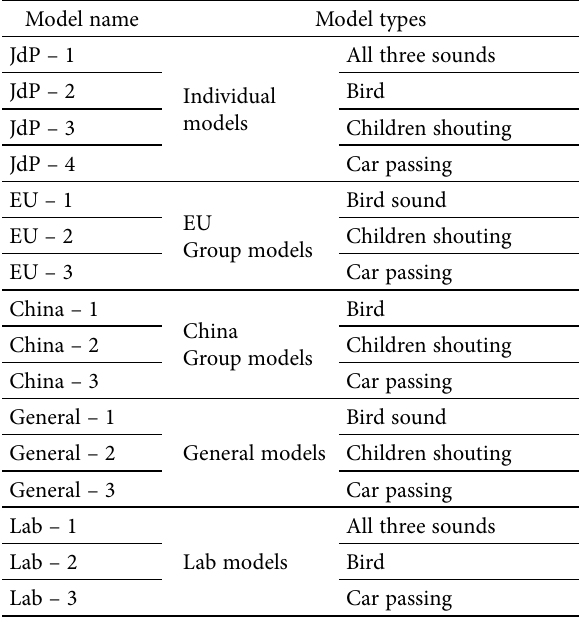
Table 1. ANN models list